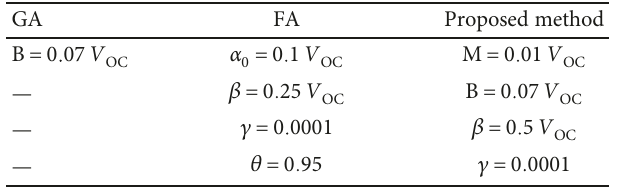
Table 4: Simulation results of FA with di ff erent population numbers under uniform irradiance.